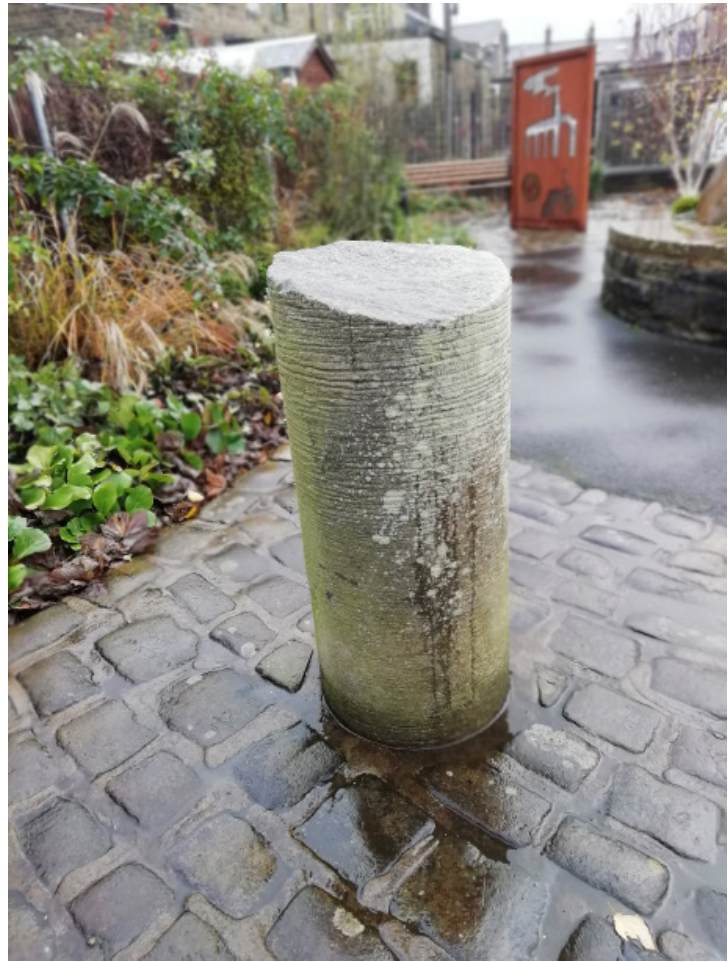
Figure 3. A section of the Barnoldswick Waterworks Borehole core now incorpo- rated into the towns sensory